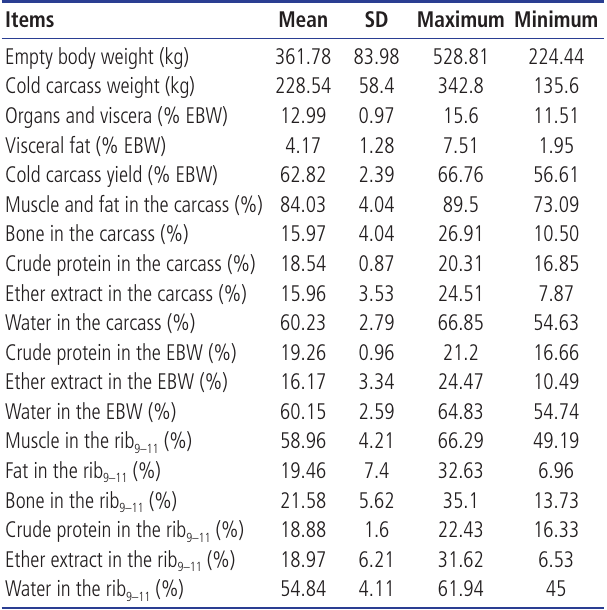
Table 3. Variables used to estimate the physical and chemical composition of the carcasses, as well as the chemical composition of the empty bodies